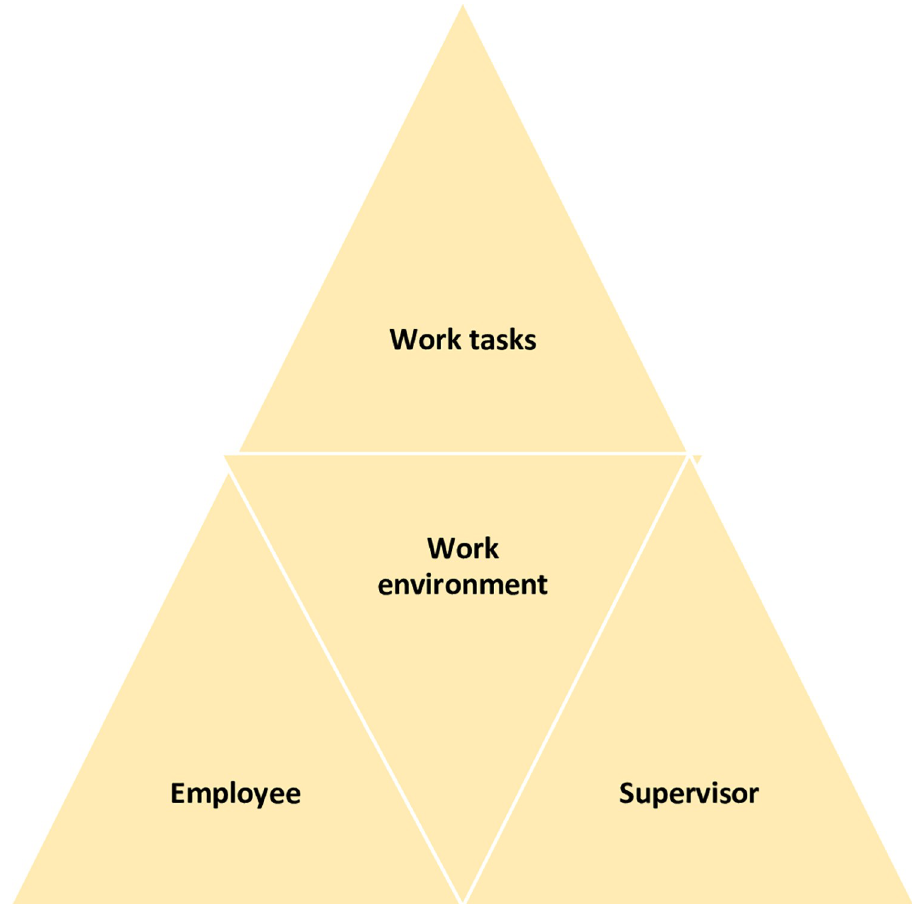
Fig 1. The health promotion approach used in the convergence dialogue